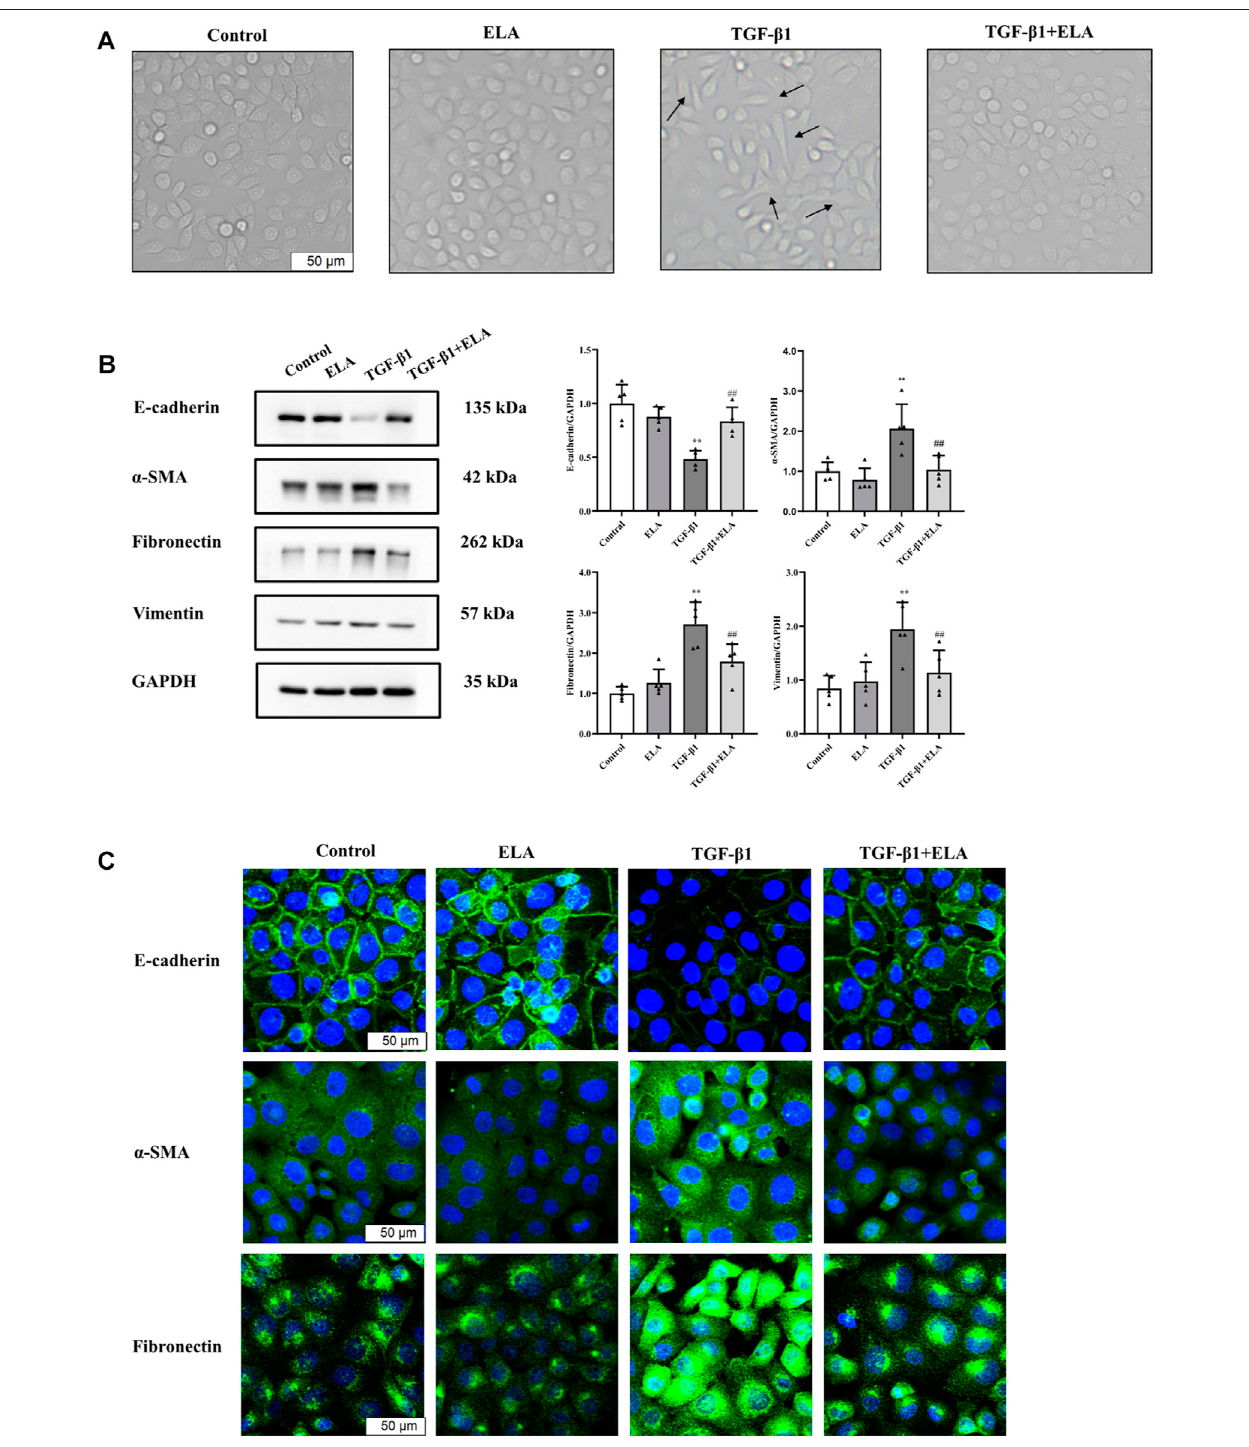
FIGURE 2 | The role of ELA in TGF- β 1-induced EMT in HMrSv5. HMrSv5 was divided into four groups according to different treatments: 1) Control group where cells were cultured withDMEM medium containing10%FBS after 24 hofsynchronization; 2)ELA group where cellsweretreated withELA-32(10 μ M) for 24 h; 3) TGF- β 1groupwherecellsweretreatedwithTGF- β 1(10 ng/ml)for24 h; andTGF- β 1+ELAgroupwherecellswereco-treated withTGF- β 1(10 ng/ml)andELA-32 (10 μ M)for 24 h. Notes (A) Light microscope was used to observe the morphological changes of human peritoneal mesenchymal cells. (B) The expression of E-cadherin, α - SMA, fi bronectin, and vimentin proteins were detected by Western blotting. The experiments were repeated fi ve times. (C) The E-cadherin, α -SMA, Fibronectin were observed by immuno fl uorescence; cell nuclei were stained with DAPI (blue fl uorescence) (scale bar = 50 μ m). In HMrSv5, E-cadherin is a green fl uorescence located in the cell membrane, α -SMA, fi bronectin is a green fl uorescence distributed in the cytoplasm. Data are expressed as mean ± SD, ** p < 0.05 vs. control group; ## p < 0.05 vs. TGF- β 1 group. Abbreviations: ELA, elabela; TGF- β 1, transforming growth factor- β 1.